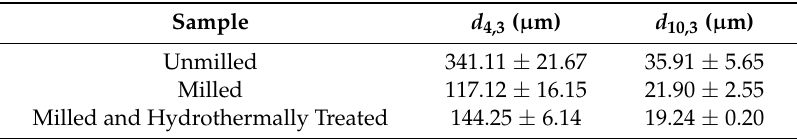
Table 1. Volume-weighted characteristic particle sizes of coffee particles examined for Pickering properties. All particles were dried prior to particle size